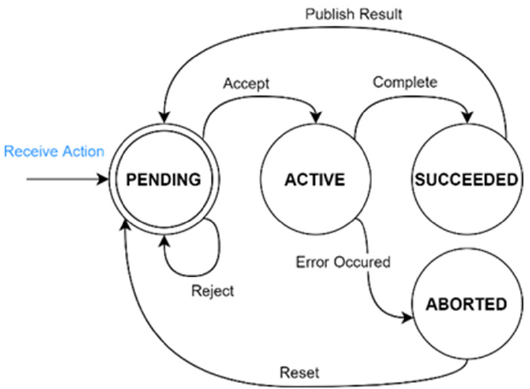
Figure 4. Resource handling state machine.